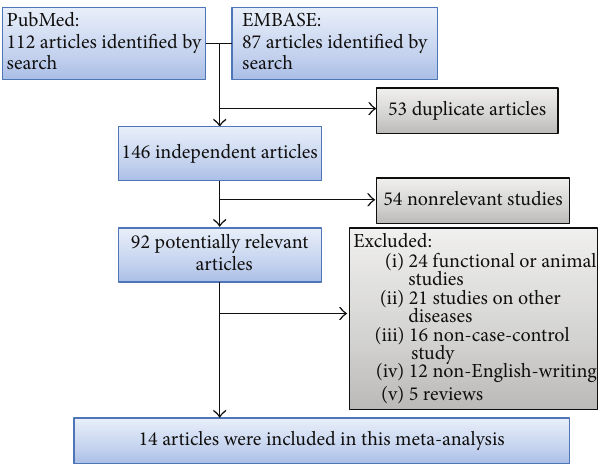
Figure 1: A schematic representation of the search strategy and selection